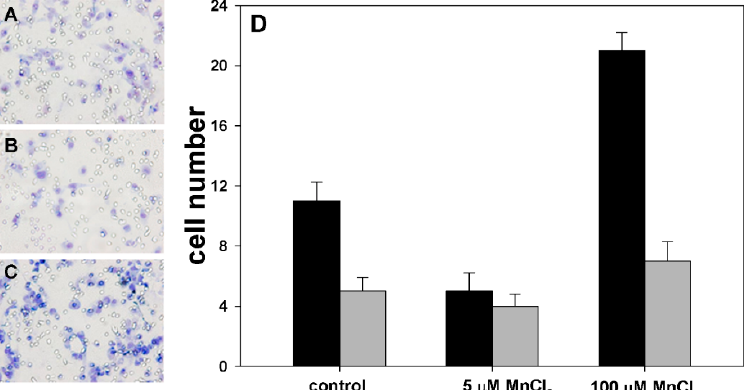
Figure 2. Representative low-magnification images captured at 6-h showing that control, ( A ) 5 µM MnCl 2 -treated ( B ), and 100 µM MnCl 2 -treated cells ( C ) migrated through the filter pores in the chemotaxis assays. Microscopic magnification = 40×. ( D ) Histogram showing the number of migrated cells in chemotaxis (black bars) and chemoinvasion assays (gray bars) in the two experimental conditions. The results are expressed as the mean ± standard error of the mean (SEM) of six different experiments.